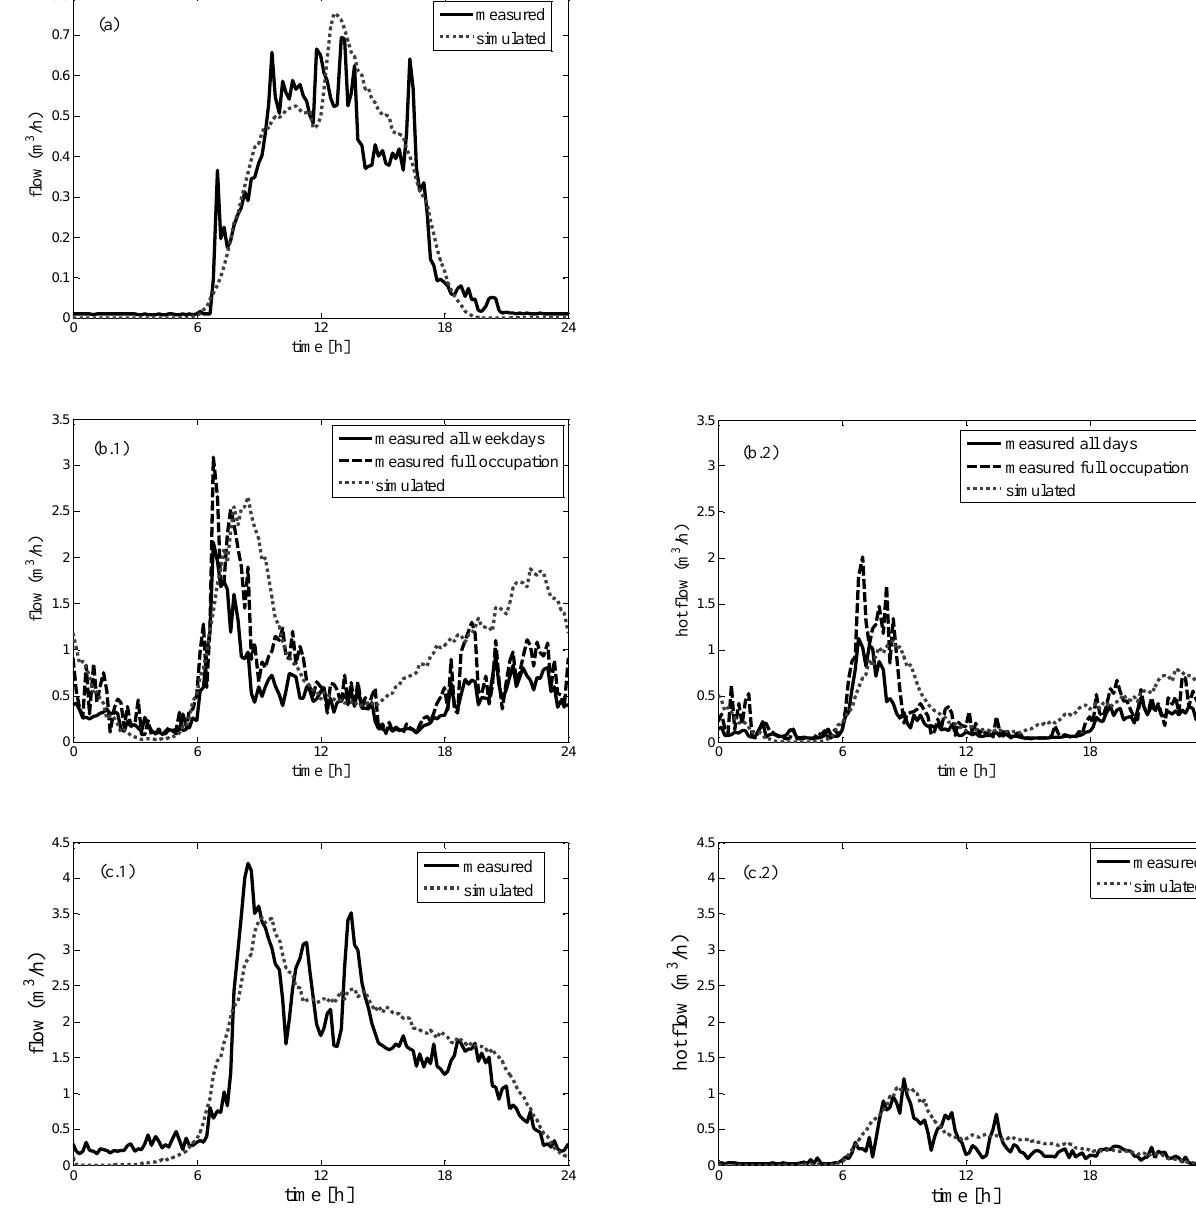
Figure 4. Comparing average measured and simulated demand of cold water of office I (a), cold water (b.1.) and hot water (b.2.) of a business hotel (II) during weekdays and cold water (c.1.) and hot water (c.2.) of a nursing home ( II) with care needed residents during weekdays.